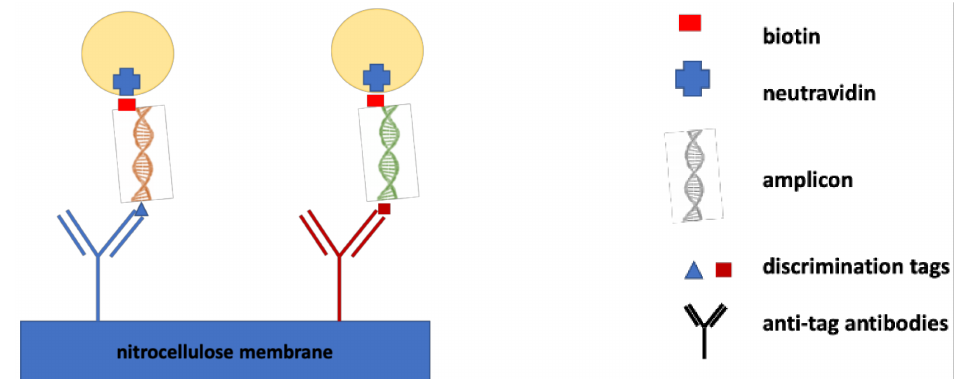
Figure 6. Schematic representation of a nucleic acid lateral flow immunoassay (NALFIA) test: neu- travidin molecules adsorbed onto gold nanoparticles (AuNPs) detect biotin-labeled amplicons. The discrimination tag is recognized by its specific antibody, immobilized onto a nitrocellulose